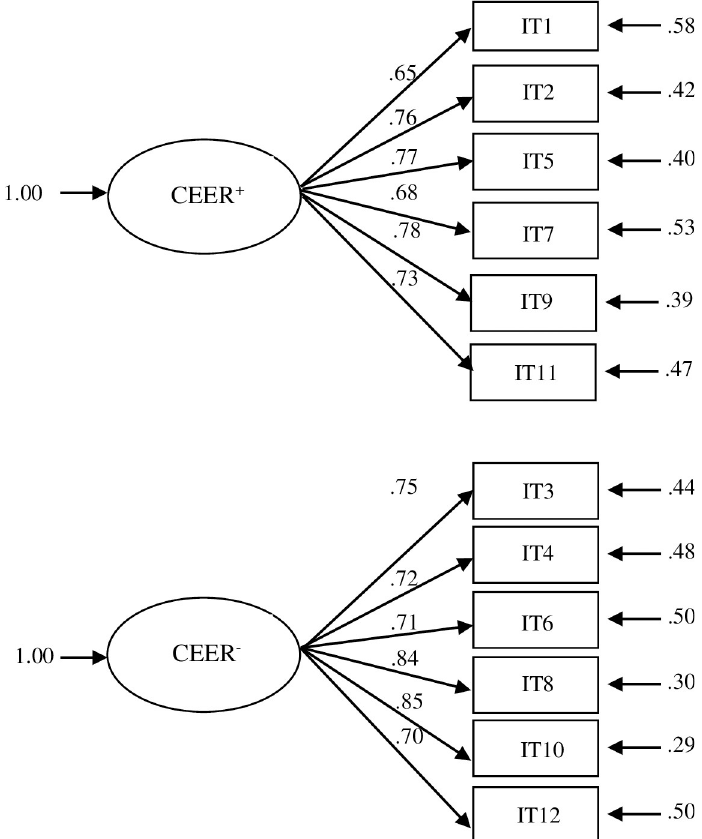
Fig 1. Standardized factor loadings for the CEER questionnaire model of two unrelated first-order factors (CEER + = positive Couples Extrinsic Emotion Regulation and CEER - = negative Couples Extrinsic Emotion